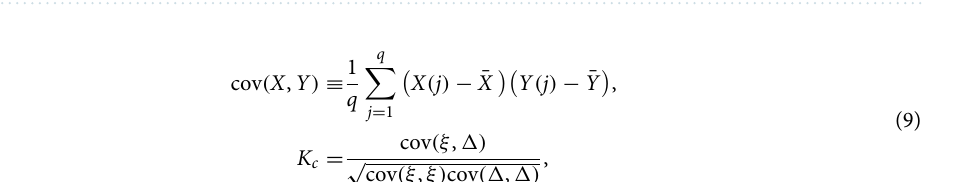
Figure 5. The phase transition diagram. The regular, limit cycle and chaotic phases are denoted by I, II and III, respectively. The parameters used are γ c /γ a = 0.5, γ m /γ a = 2, η/γ a = 5, V 0 /γ a = 20, V 1 /γ a = 40, ω r /γ a = 1, � c /γ a = − 1, and � a /γ a = −